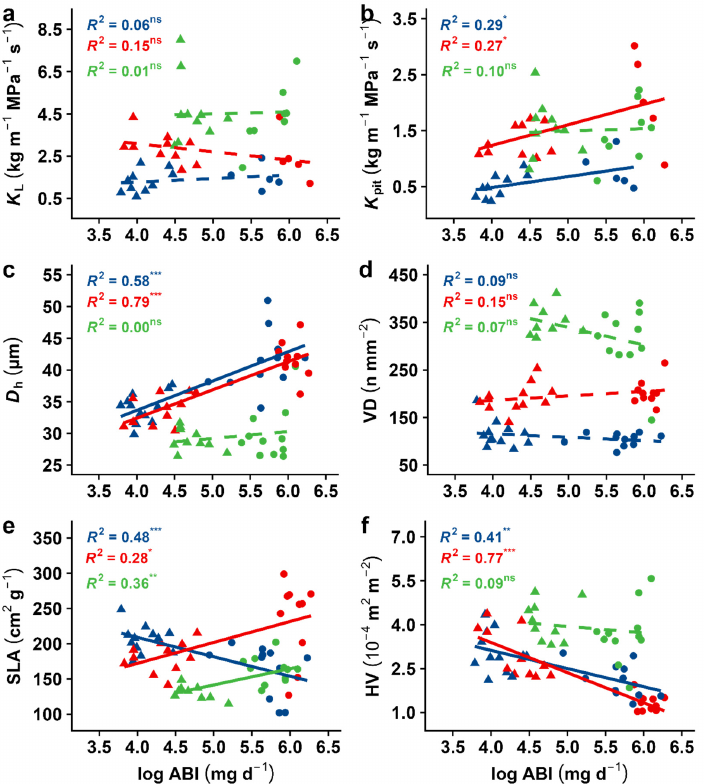
Figure 5. Dependency of growth rate on wood anatomical and leaf morphological traits. Given are linear regression analyses of log-transformed growth rate against ( a ) leaf-specific conductivity ( K L ), ( b ) pit conductivity ( K pit ), ( c ) hydraulically-weighted vessel diameter ( D h ), ( d ) vessel density (VD), ( e ) specific leaf area (SLA), and ( f ) Huber value (HV). Different colours and symbols represent dif- ferent species and treatments (blue: A. pseudoplatanus ; red: B. pendula ; green: S. aucuparia ; filled cir- cles: control treatment; triangles: stress treatment). Indicated for each species are the coefficients of determination, i.e., R-squared, for the investigated relationships. Full lines indicate significant ef- fects of variable x on variable y; dashed lines indicate a non-significant relationship. Asterisks indi- cate the level of significance ( *, p < 0.05; **, p < 0.01; ***, p < 0.001; ns, for non-significant).